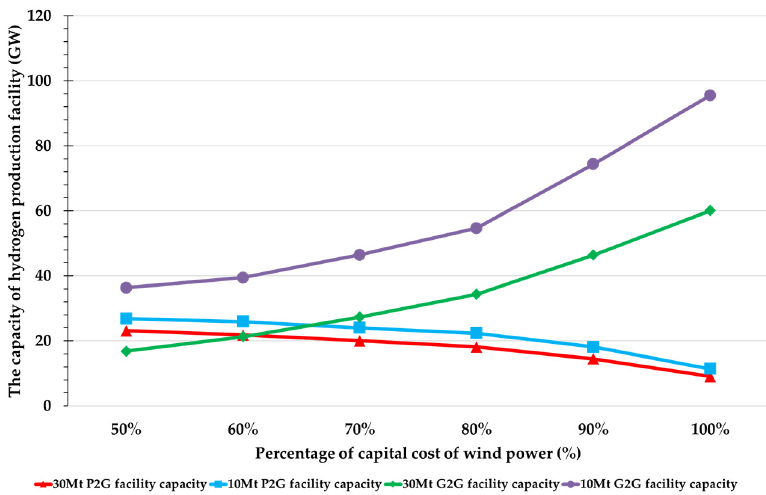
Figure 10. The sensitivity study on the capital cost of wind power.